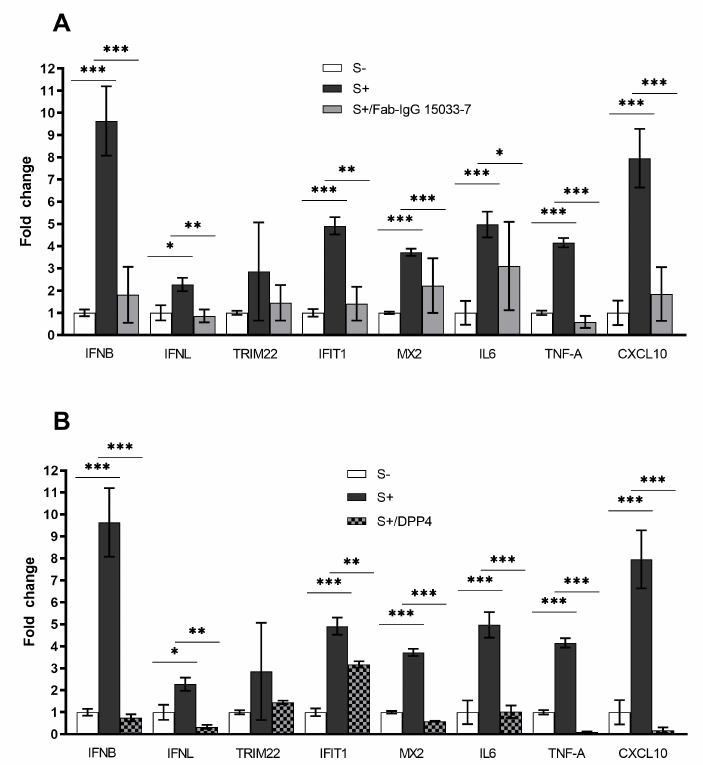
Figure 5. Expression of immunity-related genes in hLORGs . ( A ) Expression of immunity-related genes in hLORGs 48 hpi, with (S+) and without (S − ) spike protein of VSVpp.SARS-2-S, and following treatment with Fab-IgG 15033-7. Bar graph shows expression of immune response genes and cy- tokines, quantified by qRT-PCR at 48 hpi.* p < 0.05, ** p < 0.01, and *** p < 0.001 by one-way ANOVA test. ( B ) Expression of immunity-related genes in hLORGs 48 h after pseudovirus infection, with (S+) and without (S − ) spike protein of SARS-CoV-2, and following treatment with DPP4 270–295 peptide. Immune response genes and cytokines expression of was quantified by qRT-PCR at 48 hpi. Data are from three independent experiments and represented as mean ± SD. * p < 0.05, ** p < 0.01, and *** p < 0.001 by one-way ANOVA test. These data showed that the anti-inflammatory capacity of both treatments (Fab-IgG 15033-7 and DPP4 270–295 peptide) was useful to ameliorate the clinical response to